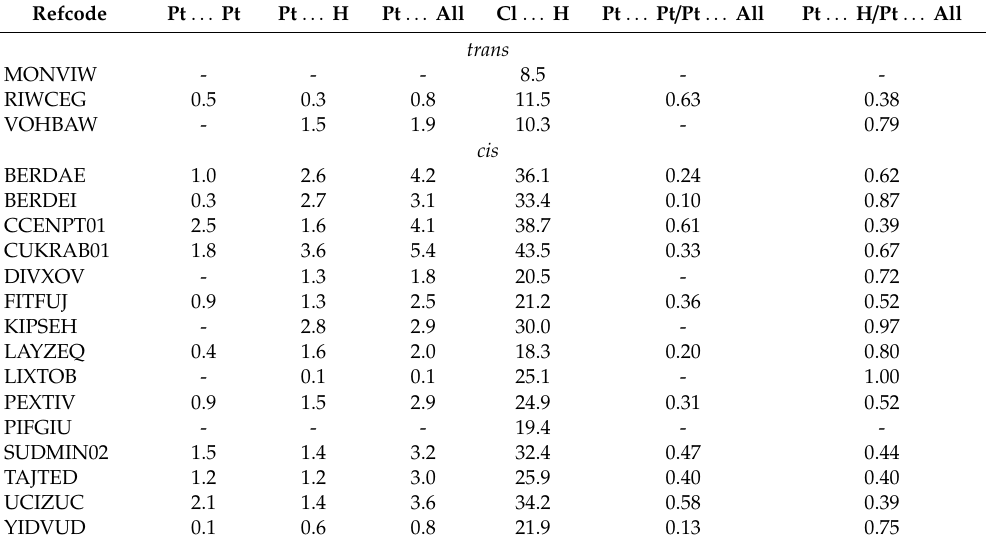
Figure 2. Molecular Hirshfeld surfaces of trans -platinum(II) complex of 3-aminoflavone (MONVIW) ( a ) and cis -diamminedichloroplatinum(II) complex (CUKRAB01) ( b ) mapped with the d norm parameter. Red areas correspond to very short and important stabilizing intermolecular contacts characterized by negative values of d norm . Table 1. Percentage of intermolecular contacts involving platinum atom resulting from Hirshfeld surface analysis of cisplatin